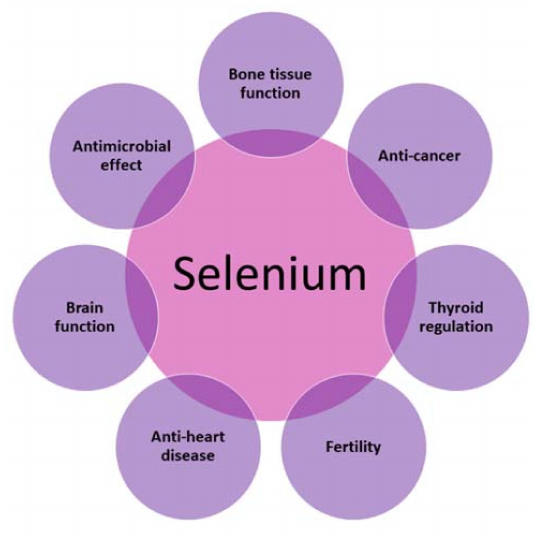
Figure 2. The health benefits of